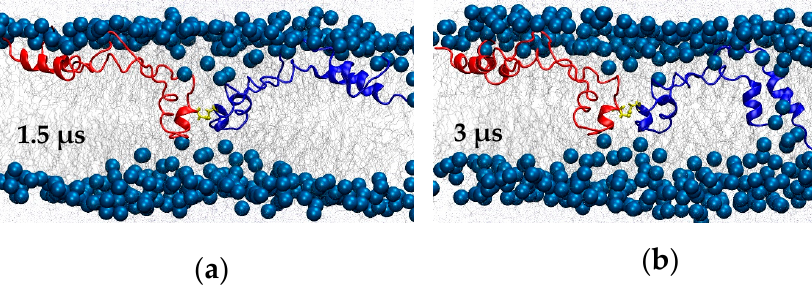
Figure 6. BI1 system snapshots at ( a ) 1.5 µ s and ( b ) 3 µ s. C48, which forms the inter-subunit disulfide bond, is shown in yellow.